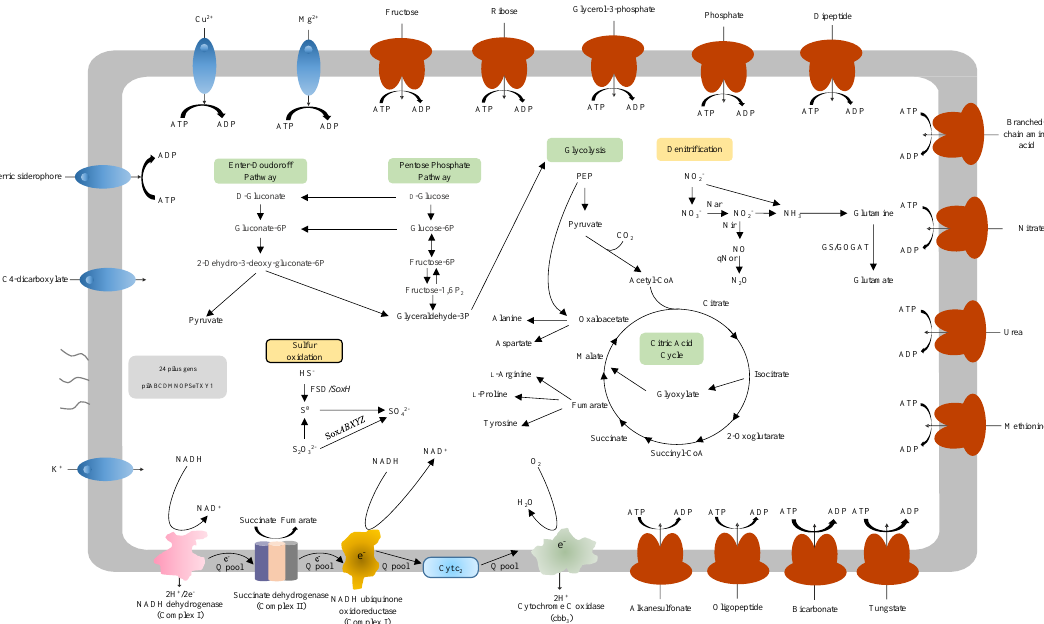
Figure 4. Model predictions for metabolism and some transporters of strain CHu59-6-5 T . Nitrogen metabolic and sulfur oxidation pathways are indicated. Several transporters and electron transport systems are shown. Two electron chains, complex I (NADH dehydrogenase) and complex II (succinate dehydrogenase), were observed. Complex II usually parallel electron transport to complex I. A C-family heme-copper cbb3 oxidase, which presumably serves as the terminal electron acceptor during aerobic respiration, was identified. The genome also encodes genes related to the type IV pilus.